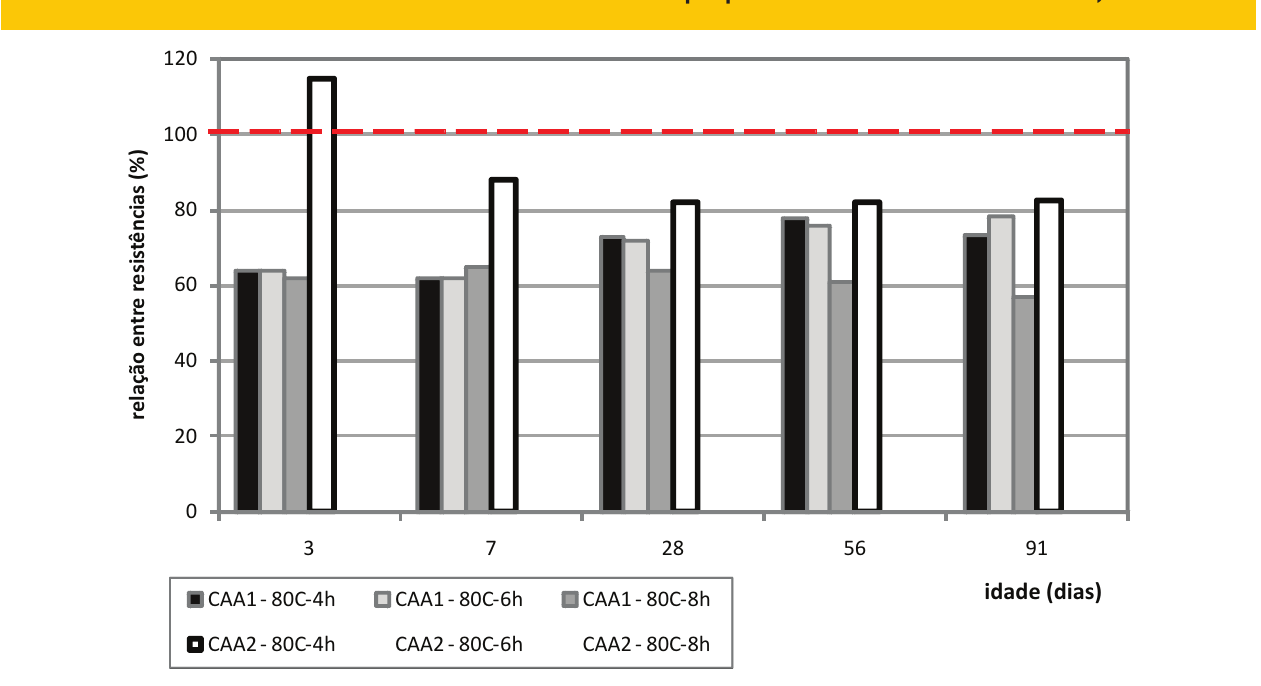
Figure 5 – Comparative analysis between the concretes studied (CAA1: concrete